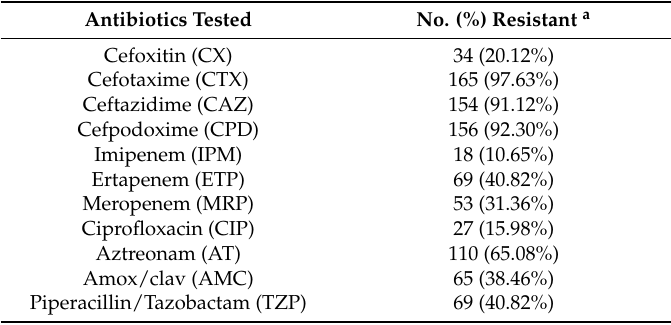
Table 3. Antimicrobial susceptibility profiles of ESBL +